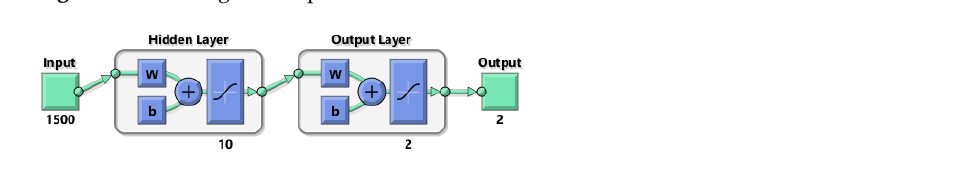
Figure 9. FFT of signal samples.